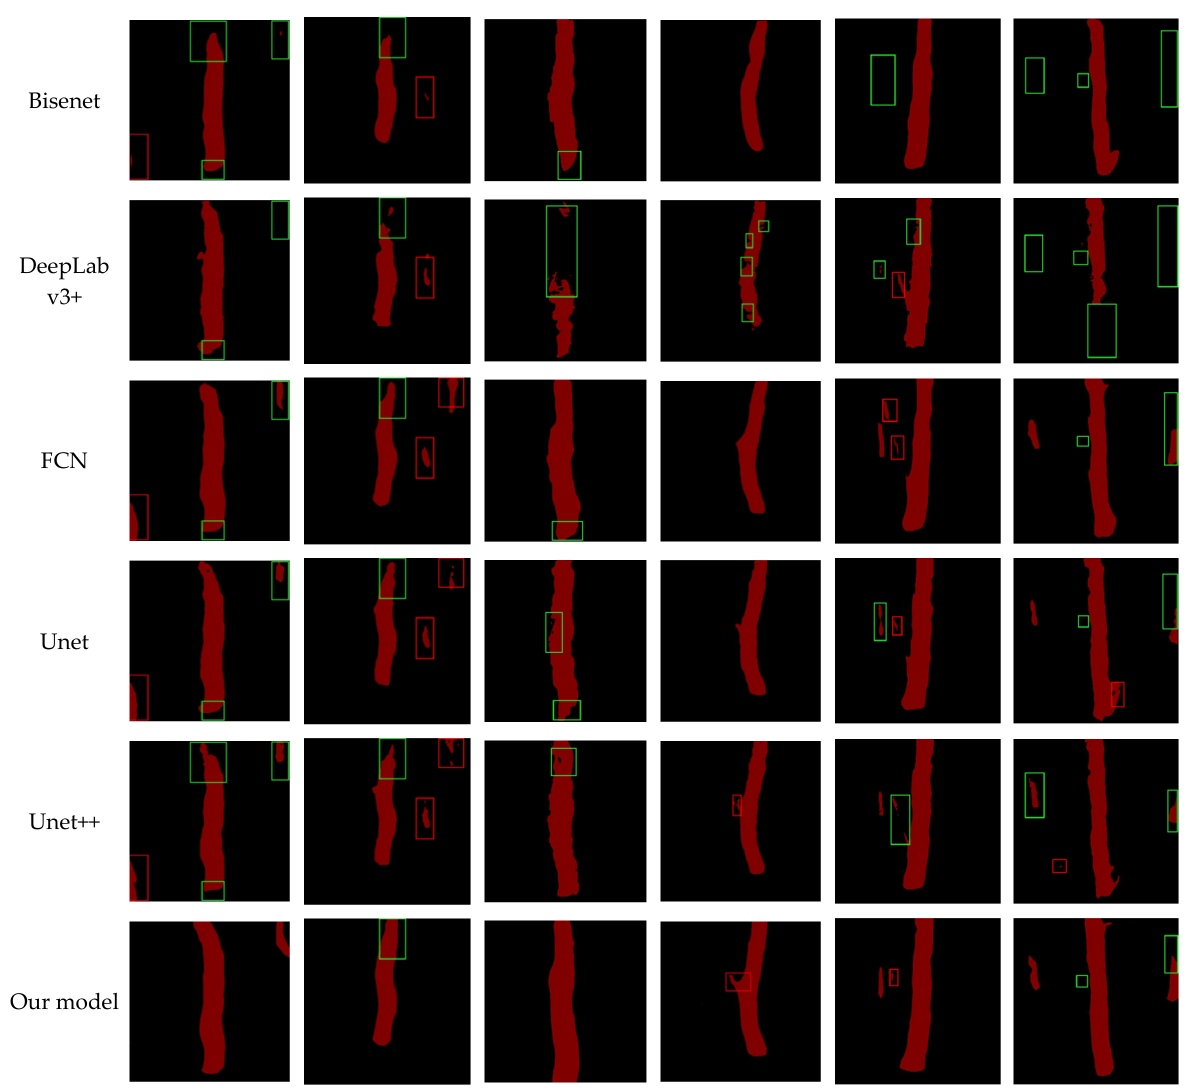
Figure 16. Segmentation results of jujube trunk by different segmentation models. Where: the red boxed area was mistakenly segmented. The green boxed area was incompletely segmented. Table 7. Experimental